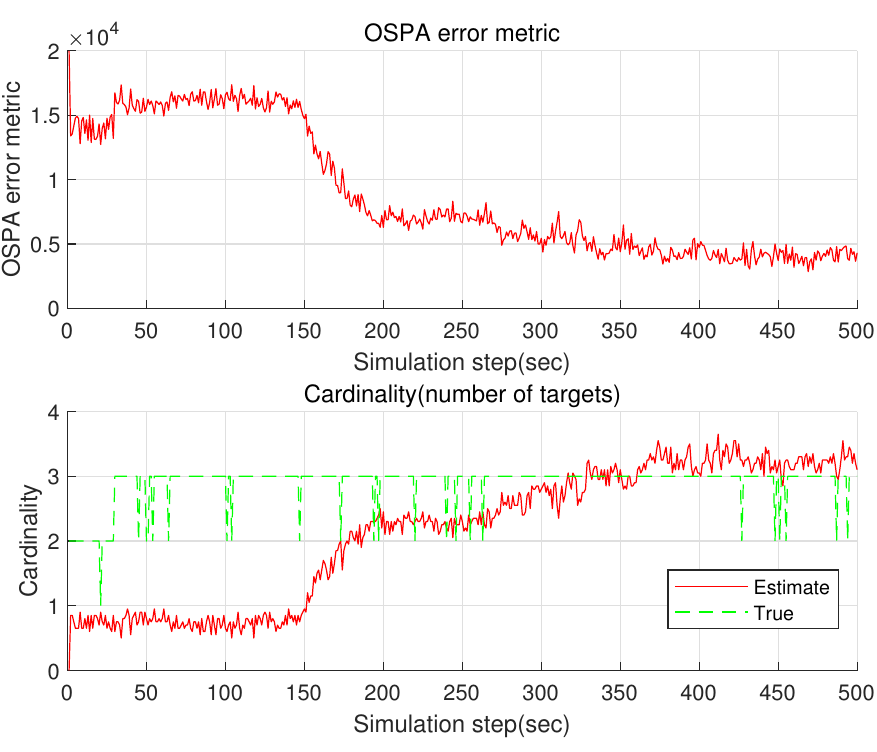
Figure 4. The OSPA and the cardinality of the proposed GM-PHD in the case where B = 50 is utilized. As time goes on, OSPA gradually approaches to zero and Estimate converges to True in